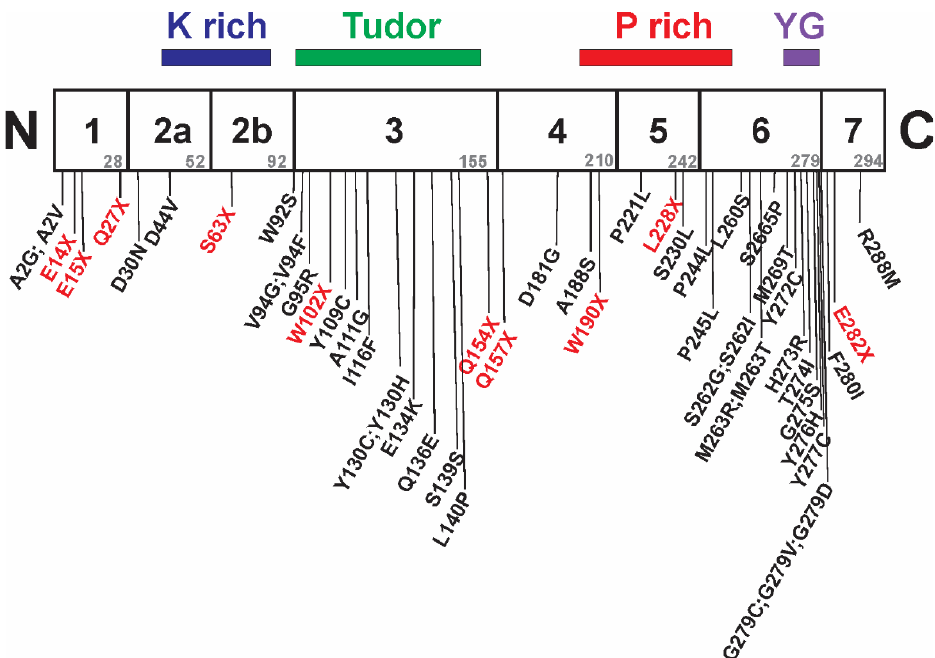
Figure 4. Location of SMA-associated intragenic missense and nonsense mutations within SMN1 relative to protein domain location. The mutated residues in red are nonsense mutations while those in black are missense mutations. Adapted from [48] .